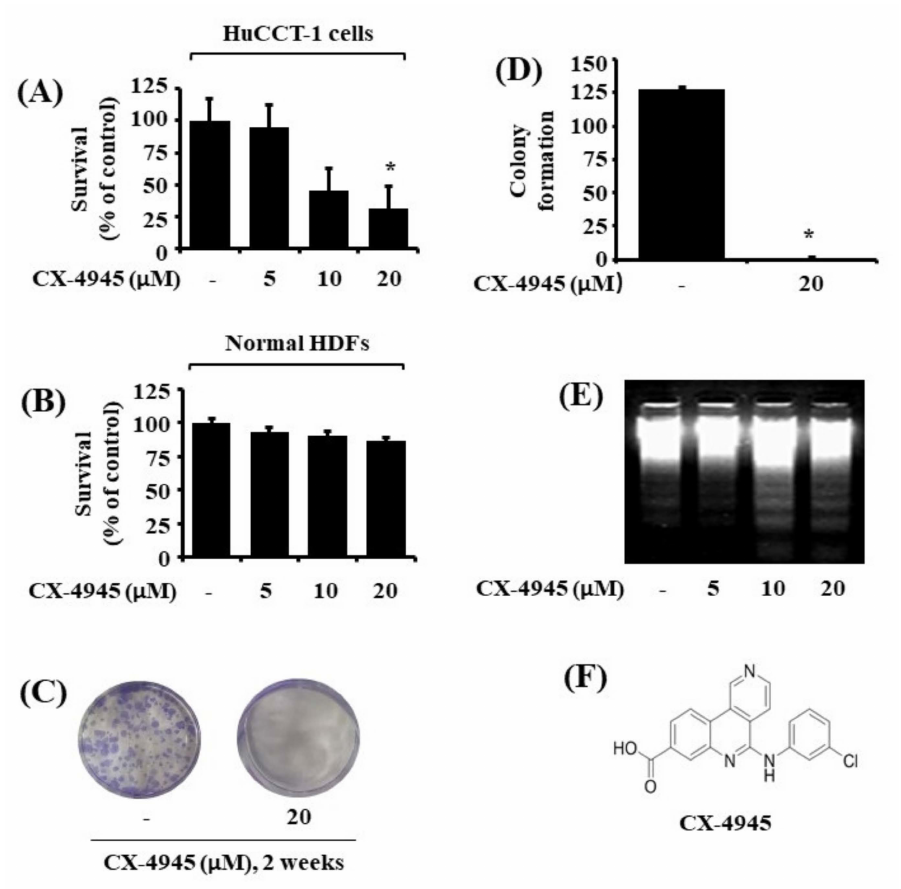
Figure 1. Effects of CX-4945 on cell growth (survival) and apoptosis (DNA fragmentation) on HuCCT-1 human cholangiocarcinoma cells. ( A ) HuCCT-1 cells were treated with CX-4945 or vehicle control (DMSO; 0.1%) at the indicated concentrations for 24 h. The number of surviving cells was measured by cell count assay. The cell count assay was performed in triplicate. Data are means ± SE of three independent experiments. * p < 0.05 compared to the value of CX-4945 or vehicle control (DMSO) for the indicated time. ( B ) Human dermal fibroblast (HDF) cells were treated with CX-4945 or vehicle control (DMSO; 0.1%) at the indicated concentrations for 24 h. The survival of surviving cells was measured by cell count assay. The cell count assay was performed in triplicate. Data are means ± SE of three independent experiments. ( C ) HuCCT-1 cells were treated with CX-4945 (20 µ M) or vehicle control (DMSO) and incubated for 2 weeks, followed by crystal violet staining. Each image is representative of three independent experiments. ( D ) Densitometry analysis of ( C ). ( E ) HuCCT-1 cells were treated with CX-4945 or vehicle control (DMSO) at the indicated concentrations for 24 h. Extra-nuclear fragmented DNA was extracted and analyzed on a 1.7% agarose gel. ( F ) The